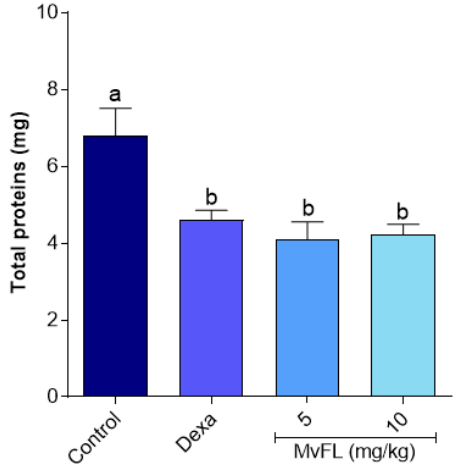
Figure 4. Total protein concentration in the peritoneal liquid from mice submitted to carrageenan- promoted peritonitis after pre-treatment with MvFL (5 and 10 mg/kg) or dexamethasone (2 mg/kg). Values are expressed as mean ± standard error of the mean ( n = 6). Different letters indicate significant ( p < 0.05) differences between treatments according to ANOVA followed by Tukey’s test.